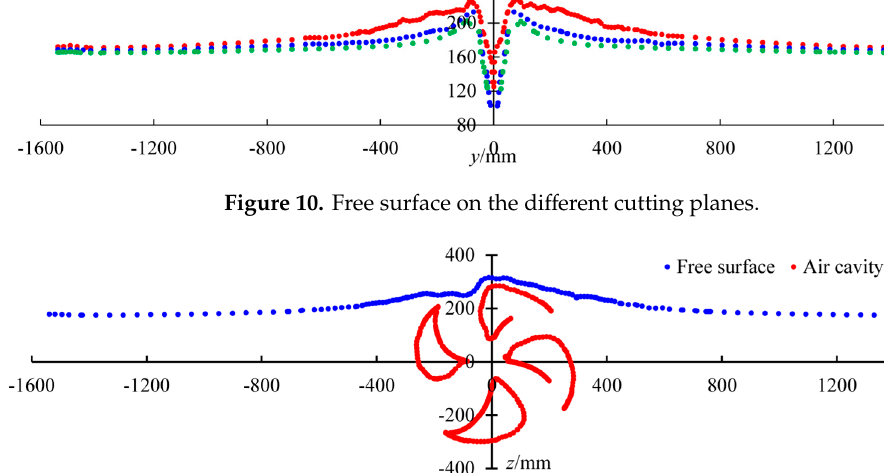
Figure 11. Air cavity and free surface at x = 0 mm .